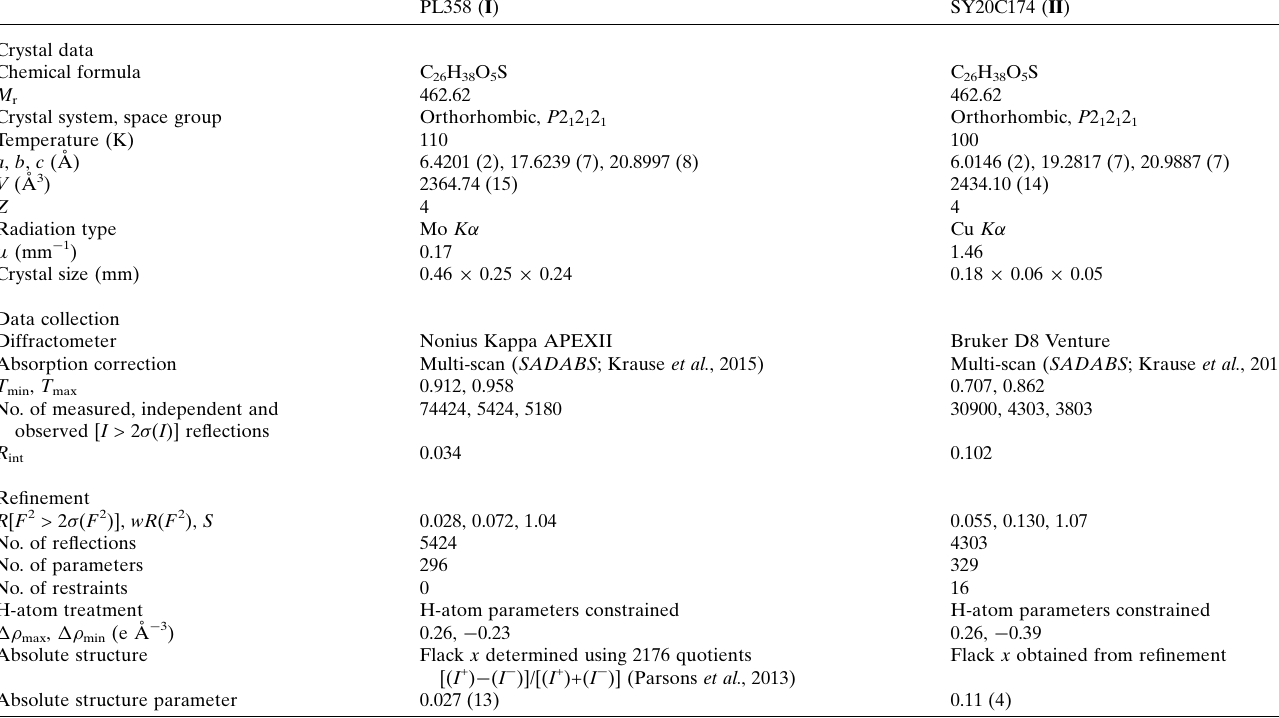
Table 5 Experimental